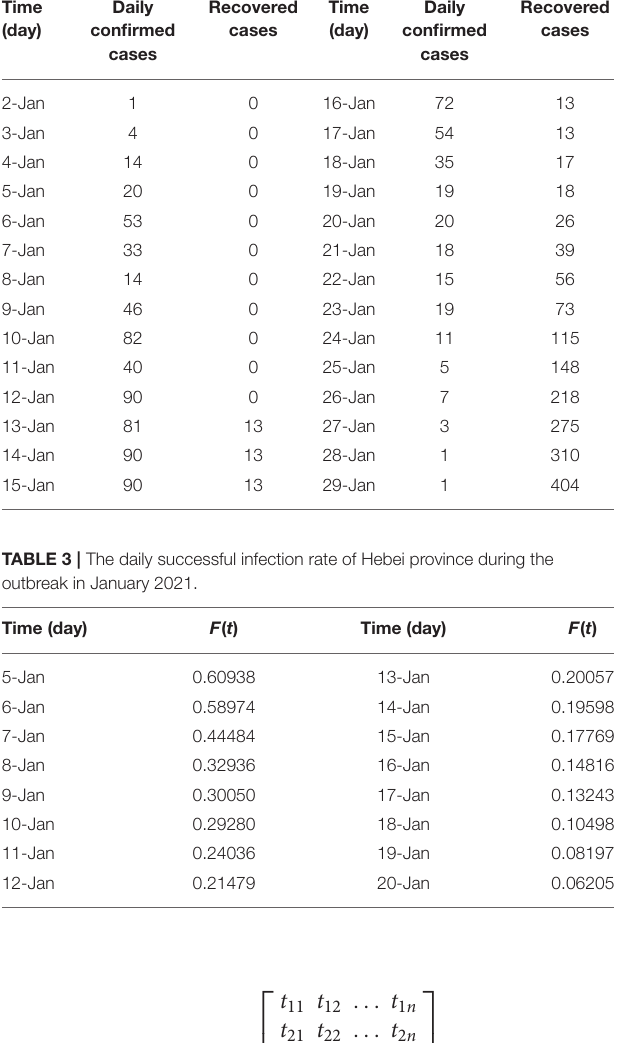
TABLE 1 | Daily confirmed and recovered cases of Heilongjiang during the outbreak in January 2021. Time (day)